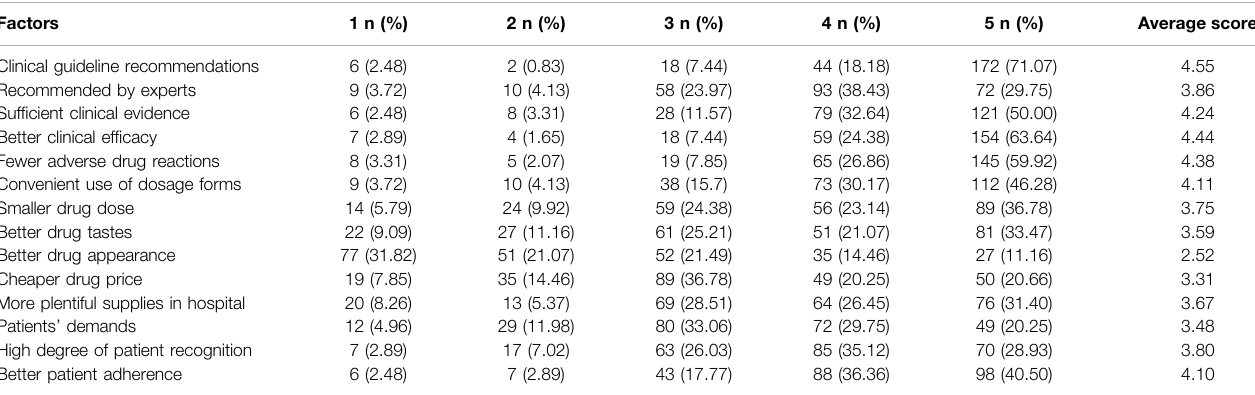
TABLE 4 | Considerations of choosing in selecting drugs (N = 242). Factors 1 n (%) Clinical guideline